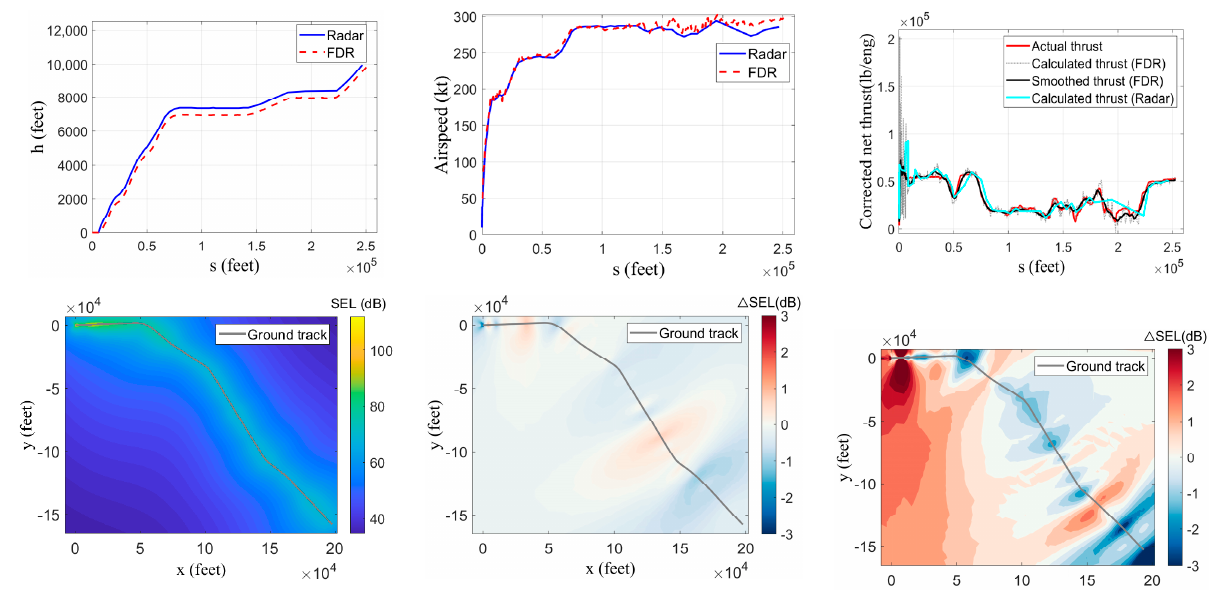
Figure 26. B777 aircraft departing from HKIA (flight BD2). Top: Comparison between the flight profile (left), airspeed (center), calculated and actual thrust (right) inferred from the FDR and radar data. Bottom: Noise contour map, as obtained using FDR data and actual thrust (left). Error entailed by an approximation of the thrust (center: smooth calculated thrust) plus the trajectory estimation (right: radar data, calculated thrust).